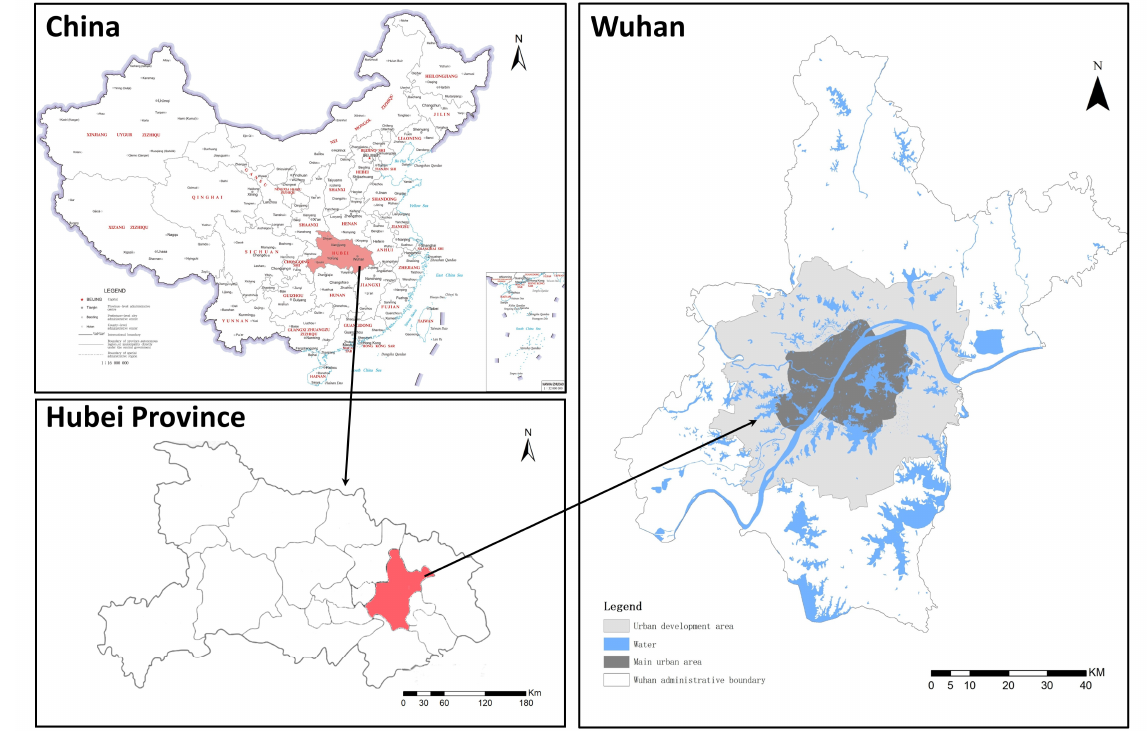
Figure 1. Location of study area.